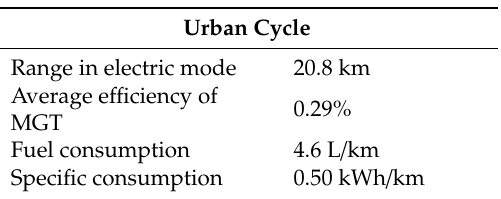
Table 17. WVUCITY cycle